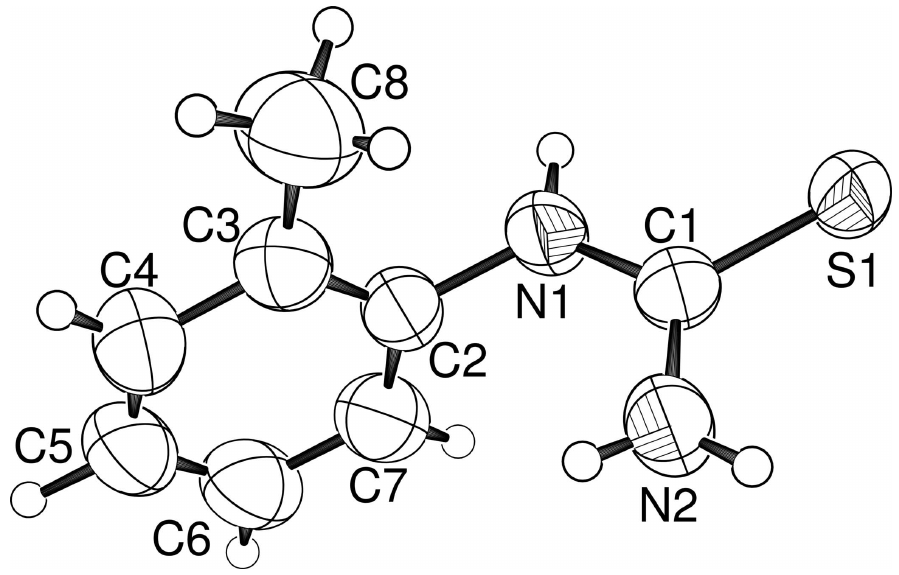
Figure 1 The title molecule with the atom-numbering scheme. The displacement ellipsoids are drawn at the 50% probability level and the H atoms are shown as small spheres of arbitrary radii.